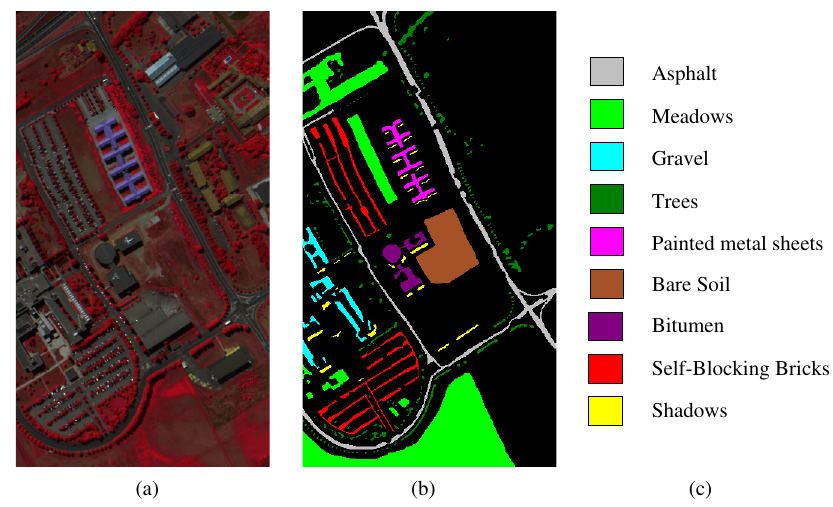
Figure 4. Pavia University scene dataset. ( a ) Three-band color composite of the Pavia University scene. ( b , c ) Ground truth image and reference data.